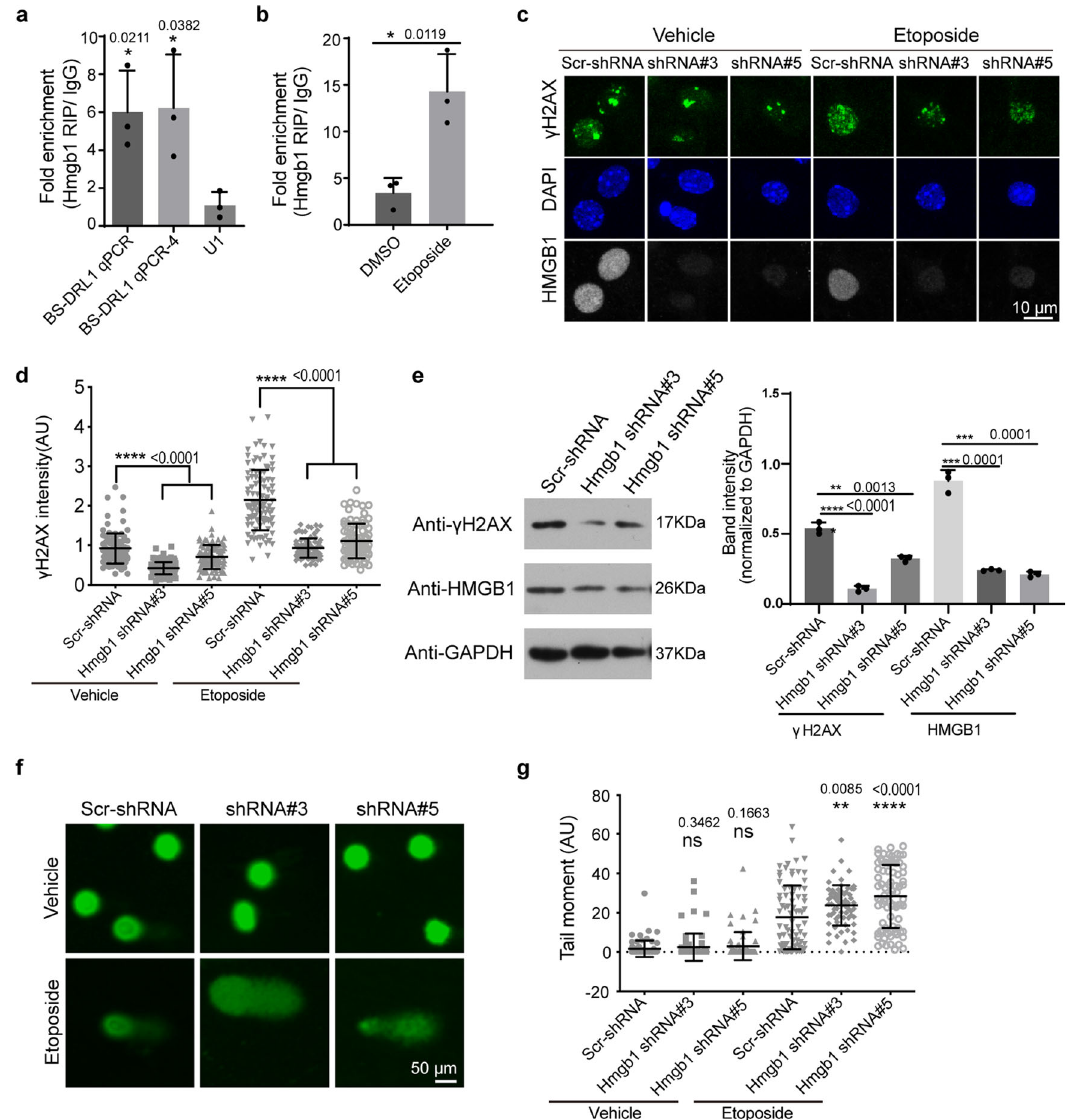
Fig. 4 BS-DRL1 functions by interacting with HMGB1. a Interaction of HMGB1 and BS-DRL1 in primary neurons was con fi rmed by RNA immunoprecipitation (RIP) with HMGB1 antibody following by RT-qPCR, U1 RNA was used as a negative control. Data are presented as mean ± SD. n = 3. b RIP-(RT-qPCR) showed an increased interaction of HMGB1 and BS-DRL1 in neurons upon DNA damage. Primary neurons were treated with DMSO or ETO for 1 h and harvested for following experiments. Data are presented as mean ± SD. n = 3. c , d DNA damage in HMGB1 KD neurons was evaluated by γ H2AX immunostaining. Primary neurons infected with indicated shRNAs virus were treated with vehicle or etoposide for 1 h and stained with γ H2AX and HMGB1 antibodies. Scale bar: 10 μ m. Data are presented as mean ± SD. n = 85 neurons. **** p < 0.0001. AU, arbitrary units. e The level of γ H2AX in neurons expressing HMGB1-shRNA was measured by western blot analysis. Primary neurons infected with indicated shRNAs virus were treated with vehicle or ETO for 1 h before harvesting for Western blotting with indicated antibodies. Data are presented as mean ± SD. ** p < 0.01, *** p < 0.001, **** p < 0.0001. n = 3 biologically independent experiments. f , g Comet assay to measure the DNA damage accumulation in neurons. Primary neurons infected with indicated shRNA virus were treated with vehicle or ETO for 1 h and then proceeded for comet assay. Scale bar: 50 μ m. Data are presented as mean ± SD. n = 63 neurons. **** p < 0.0001, ** p < 0.01, ns not signi fi cant, AU arbitrary